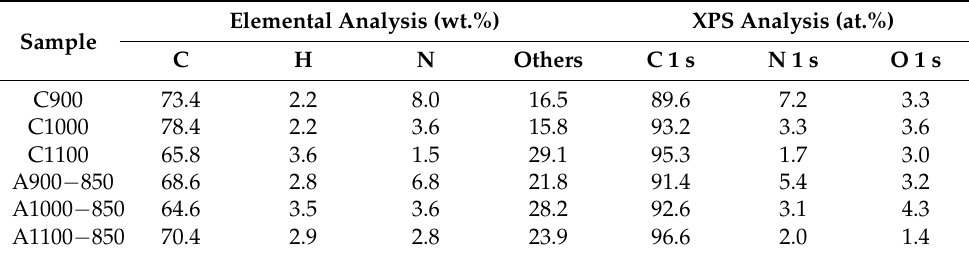
Table 1. Elemental compositions from the elemental analysis (wt.%) and XPS analysis (at.%). Elemental Analysis (wt.%) XPS Analysis Sample